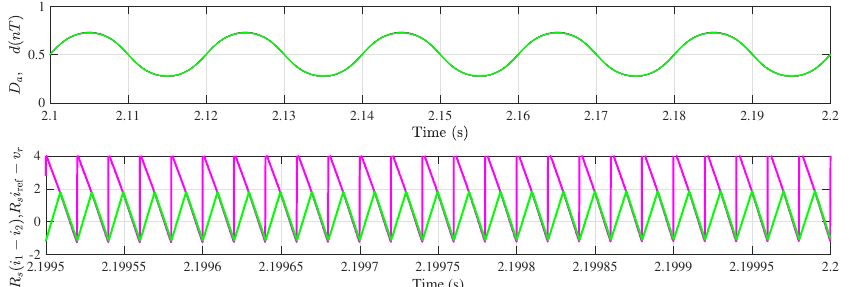
Figure 14. The time varying duty cycle calculated from (12) ( D ( t ) ) obtained from numerical sim- N ) for guaranteeing a deadbeat response within the complete duty cycle ulation ( d ( nT ) , n ∈